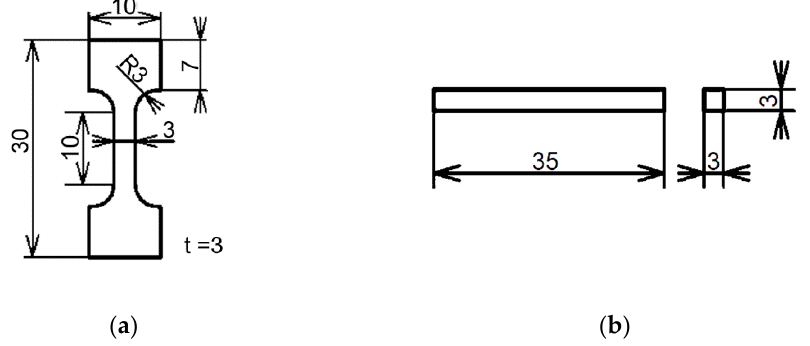
Figure 1. Shapes and dimensions of ( a ) the tensile test piece [28] and ( b ) the flexural test piece.